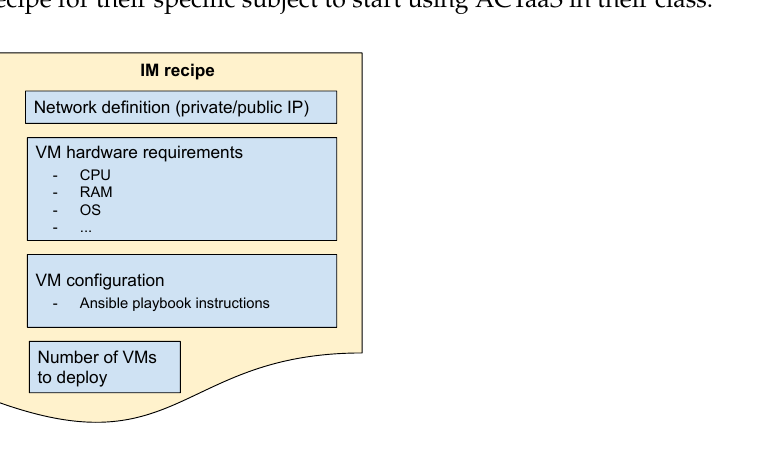
Figure 2. Schema of the structure of a recipe for the Infrastructure